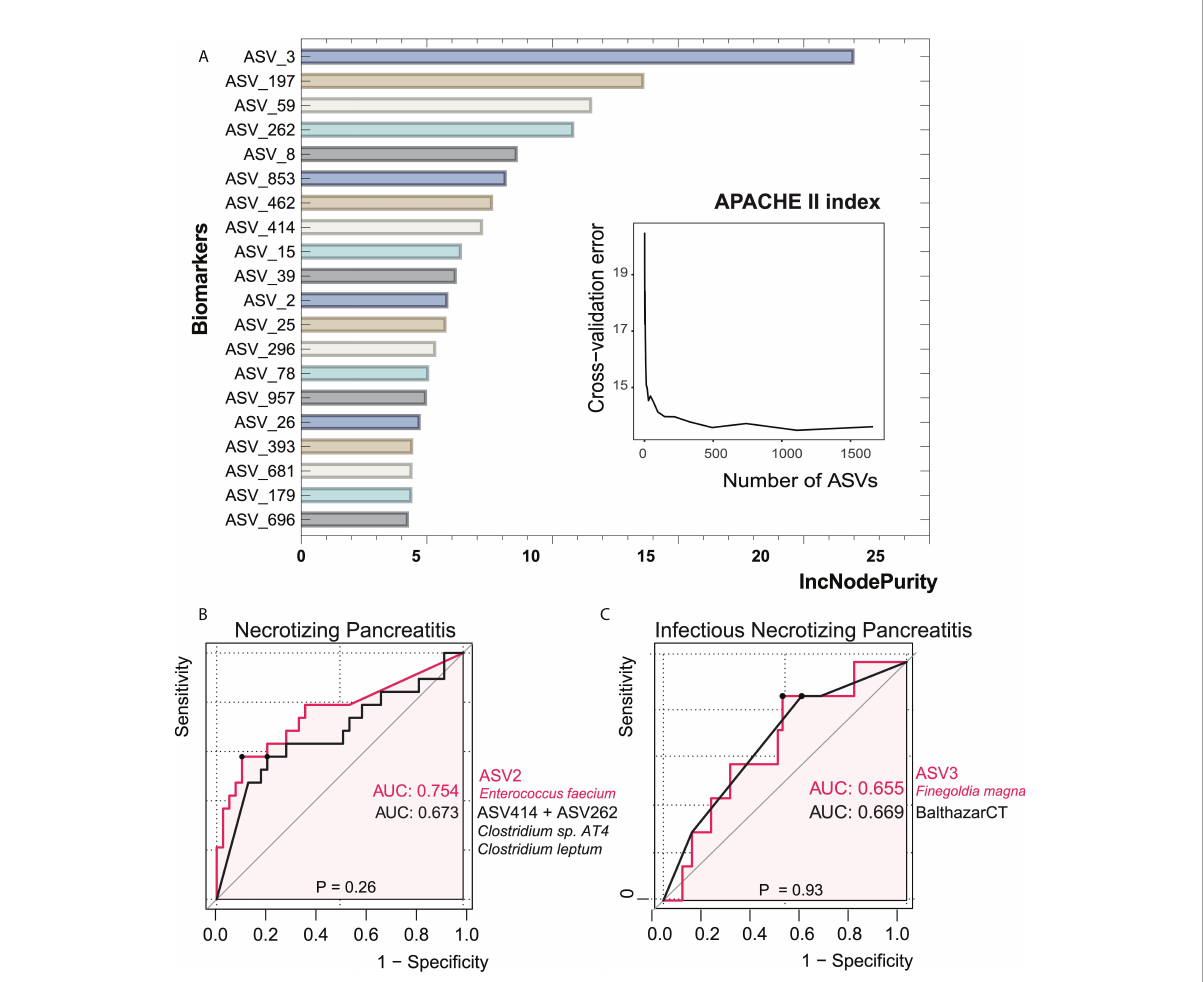
FIGURE 6 Bacterial taxonomic biomarkers of the APACHE II index in acute pancreatitis. (A) The top 20 biomarker bacterial classes were identi fi ed by applying random forests regression to their relative abundance values. Potential biomarker taxa are ranked in descending order of importance to the accuracy of the model. The inserted fi gure shows the 10-fold cross-validation error as a function of the number of ASVs used to regress against the APACHE II index in order of variable importance. (B, C) ROC curves showed the ability of speci fi c microbiome biomarker in discriminating necrotizing pancreatitis and infectious necrotizing pancreatitis. AUC, area under ROC